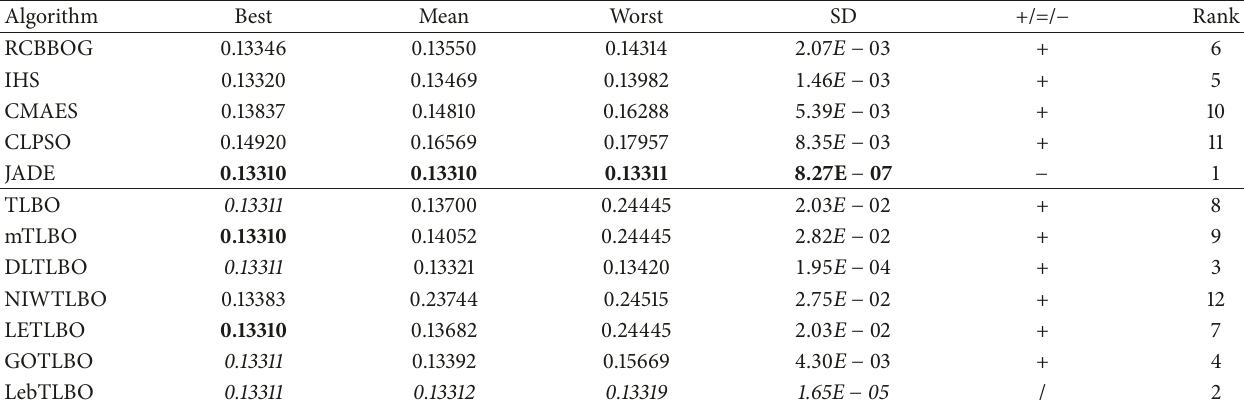
Table 8: Simulation results on the multimodal CSTR